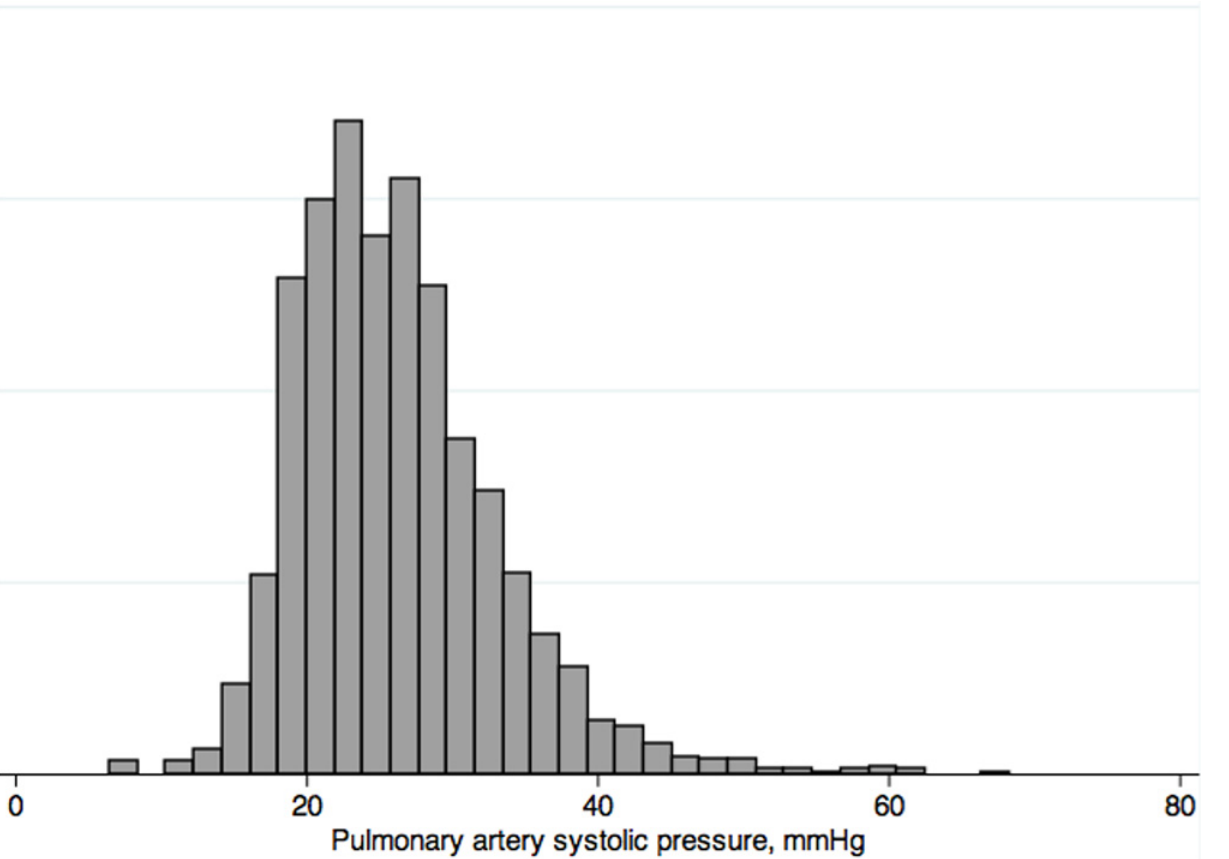
Fig 1. Distribution of pulmonary artery systolic pressure in 1945 participants in whom it could be